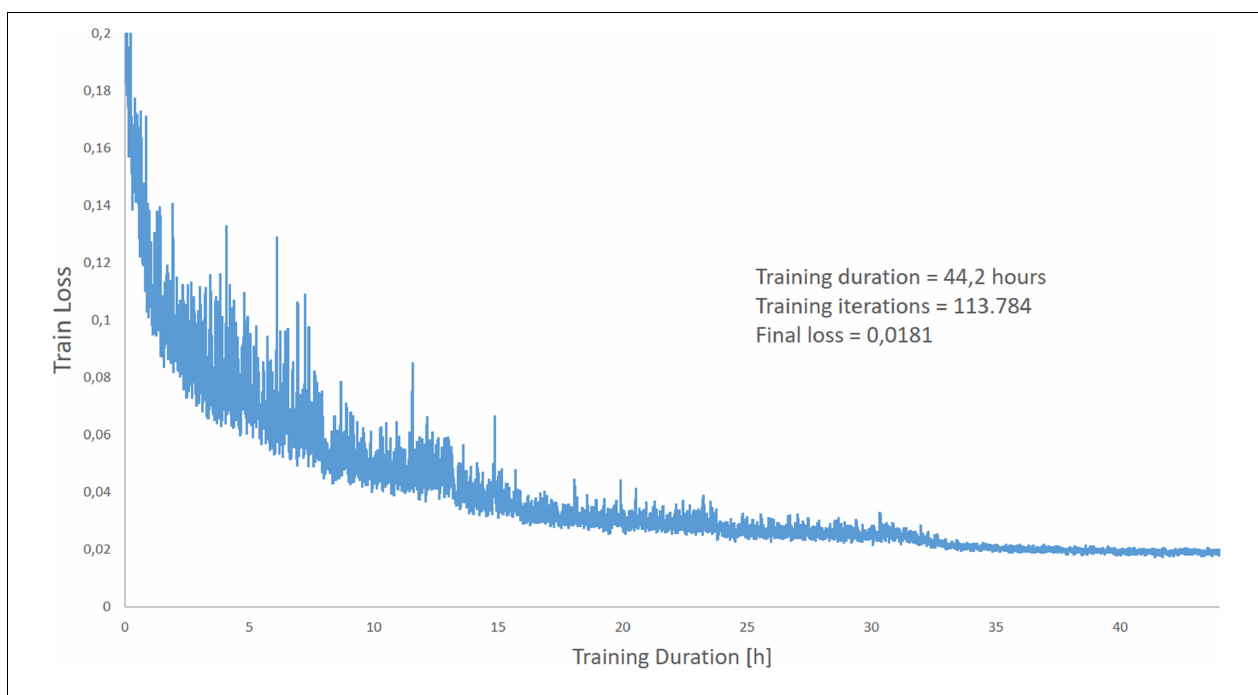
FIGURE 5 | Graphical representation of the loss during the training period over 44.2 h.